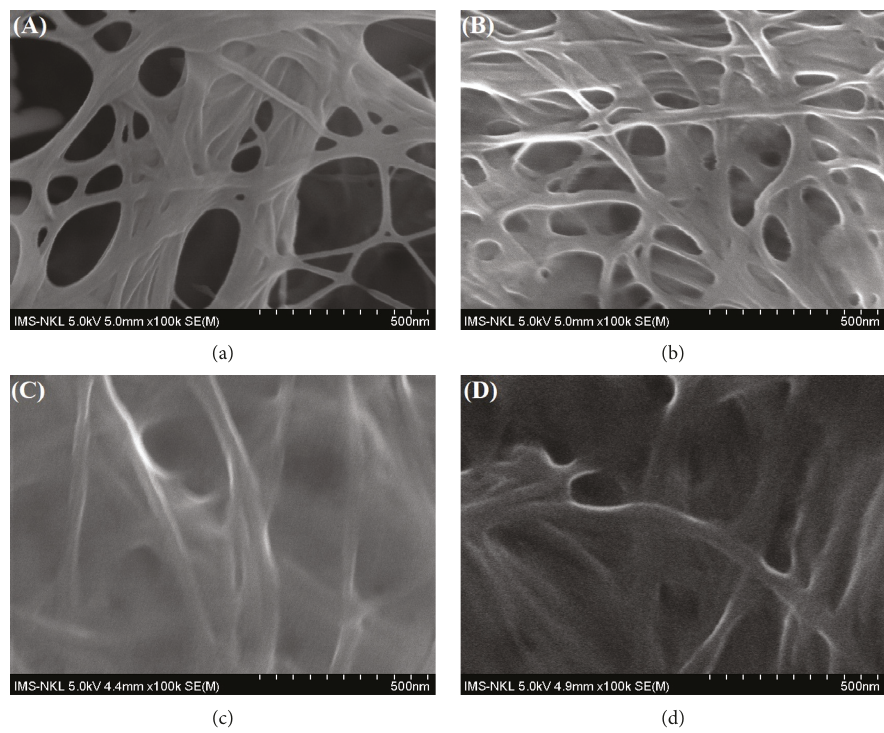
Figure 2: Scanning electron microscopy images of bacterial cellulose treated by sonication for 15min (d), 30min (c), 60min (b), and 90min